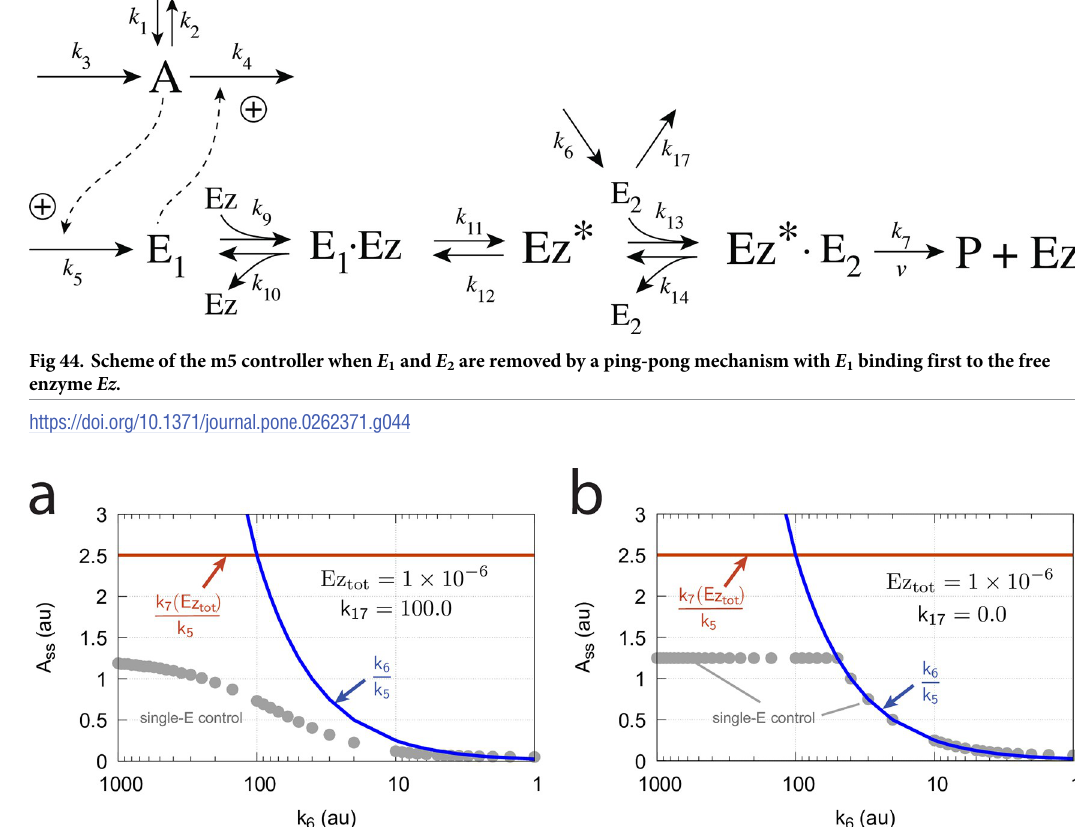
=3.97 × 10 − 7 . Simulation time: 5000 time units, 0